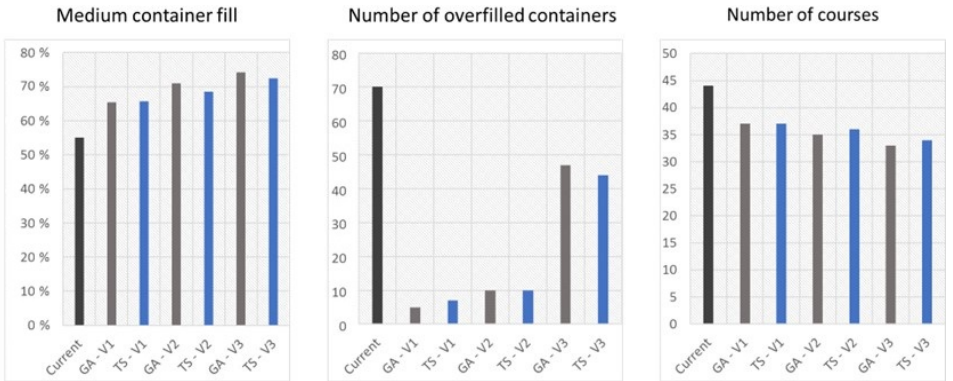
Figure 7. Simulation results for each variant using both algorithms.